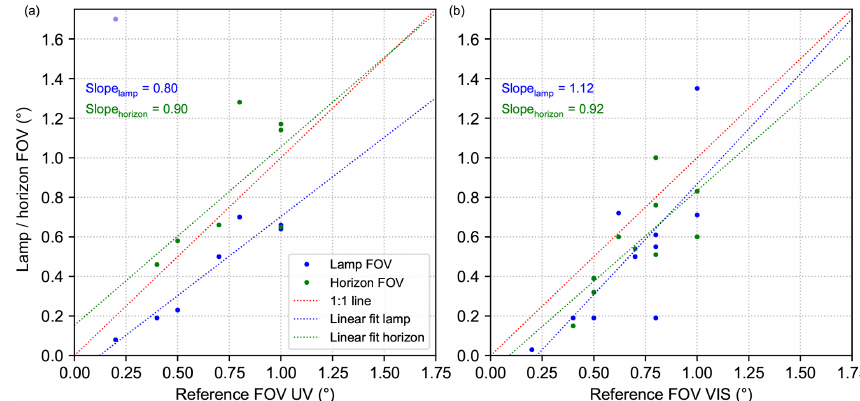
Figure 21. Correlation between retrieved FOVs from horizon scans (green dots) and far-lamp measurements (blue) against their correspond- ing reference FOVs reported by the groups. Panel (a) shows the results for the UV spectral range, while panel (b) displays the same for the visible spectral range. In both plots linear regressions and 1 : 1 lines are included in the respective colours.